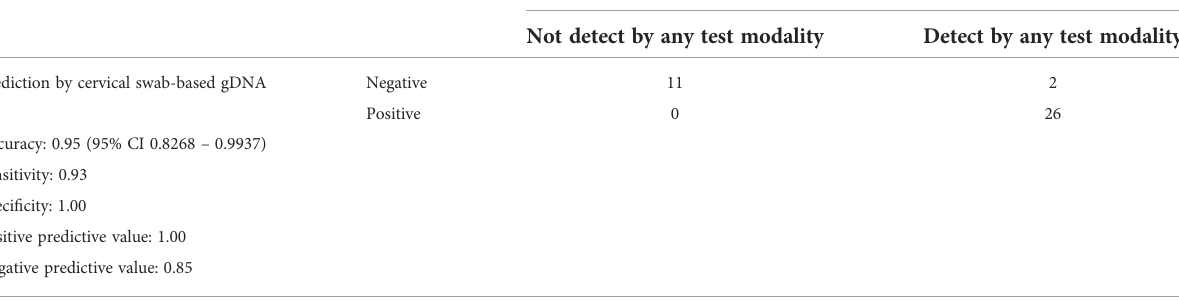
TABLE 4 Performance of cervical swab-based genomic DNA (gDNA) for detection among endometrial cancer patients. .